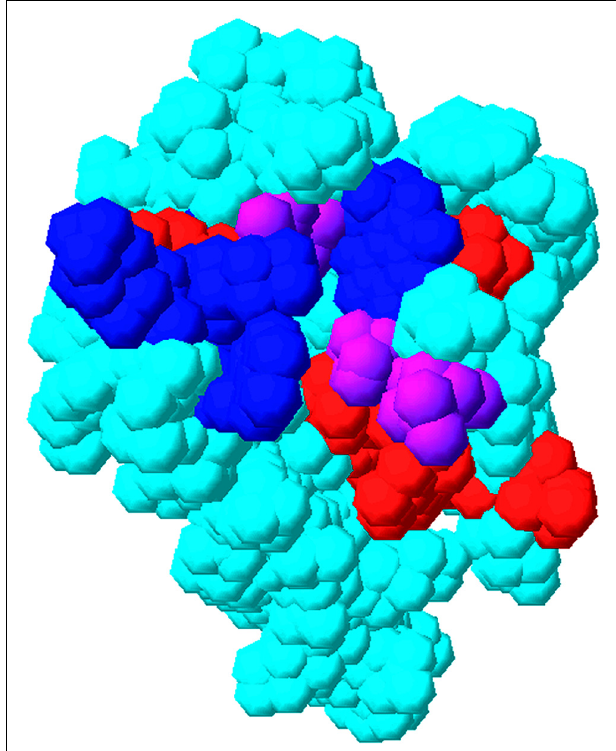
FIGURE 5 | Overlap of matrix RNA and PI(4,5)P2 binding sites. The membrane-binding surface of the HIV-1 matrix protein (PDB 1UPH) is illustrated as a space-filling model. Residues that have been implicated in PI(4,5)P2 binding are indicated in blue, residues that have been implicated in RNA binding (Alfadhli etal., 2011) are indicated in red, and residues that have been implicated in both PI(4,5)P2 and RNA binding are indicated in